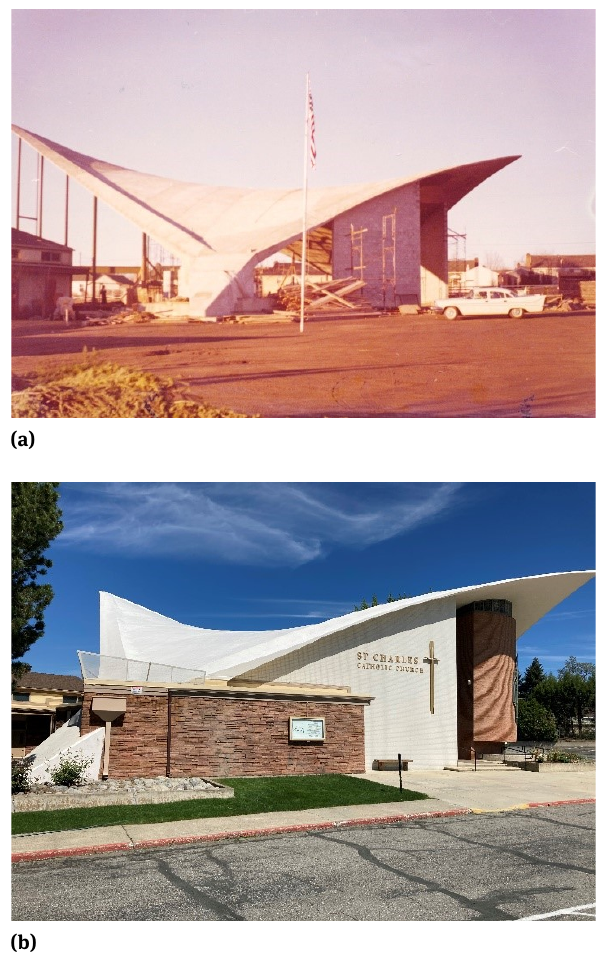
Figure 1: a) Hypar Roof in 1960 and b) Roof in